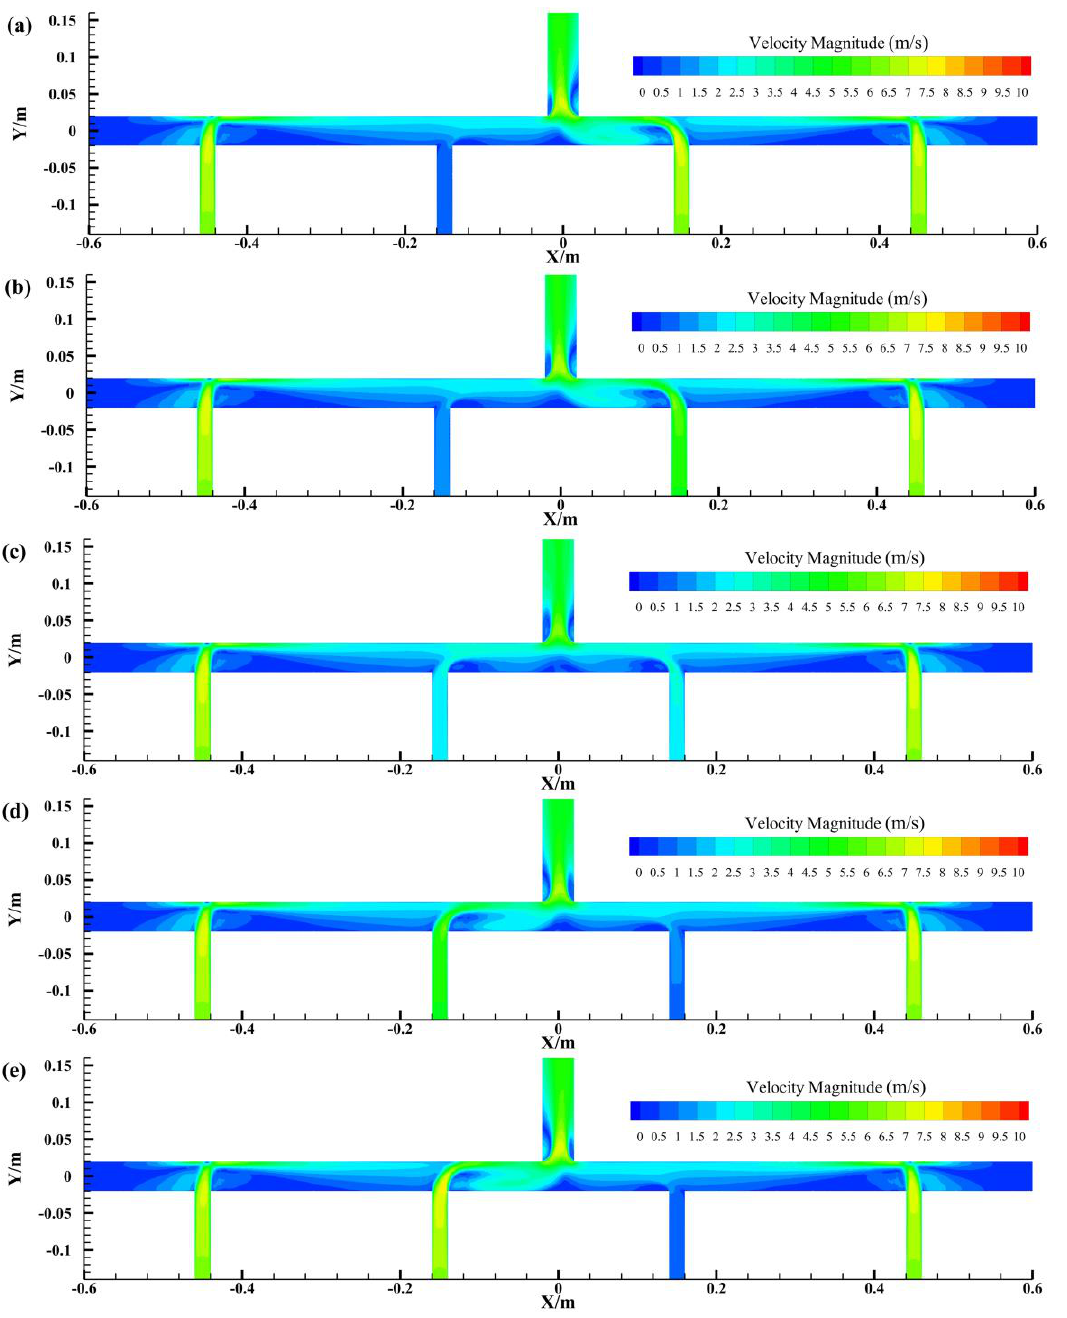
Figure 10. Velocity magnitude contours at the various times: ( a ) 10 s; ( b ) 13 s; ( c ) 15 s; ( d ) 17 s; ( e ) 20 s.